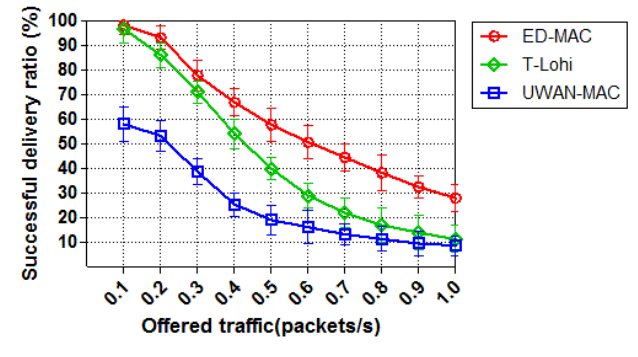
Figure 11. Successful delivery ratio vs. offered traffic.